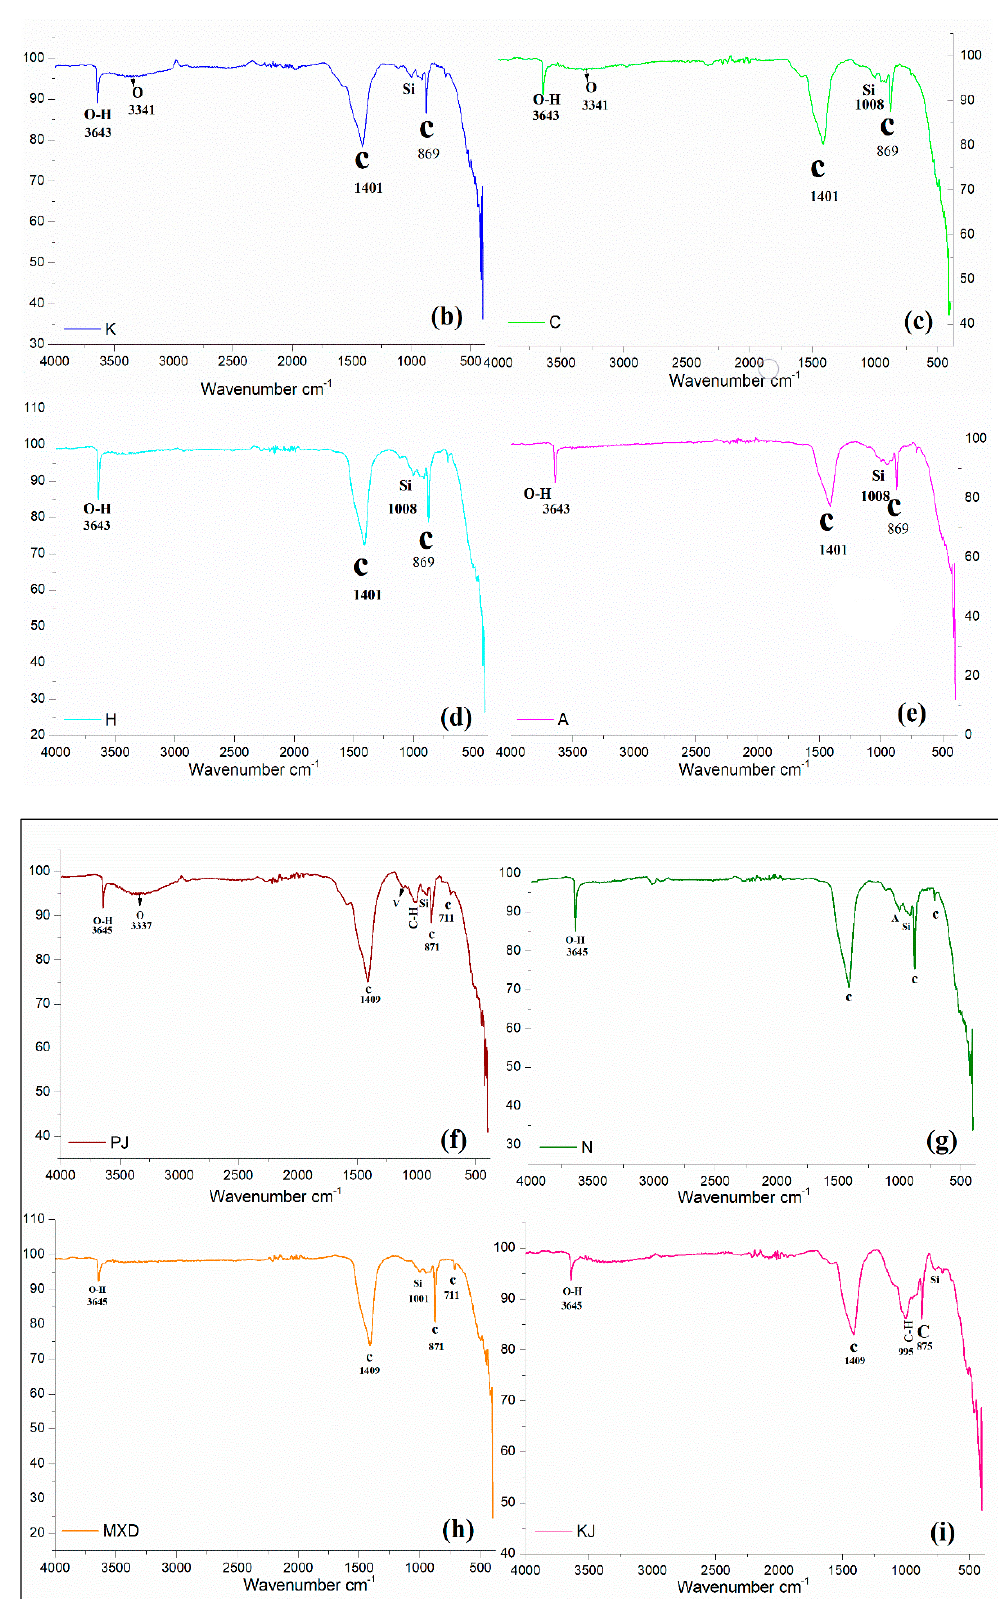
Figure 5. FT-IR patterns at 28 days: ( a ) reference lime mortar; ( b ) kadukkai lime mortar; ( c ) cactus lime mortar; ( d ) hibiscus lime mortar; ( e ) aloe vera lime mortar; ( f ) jaggery mortar; ( g ) neelamari lime mortar; ( h ) kadukkai + jaggery + aloe vera (MXD) mortar and ( i ) kadukkai + jaggery mortar; C: calcite, Si: silica, O-H: portlandite, O: organics.